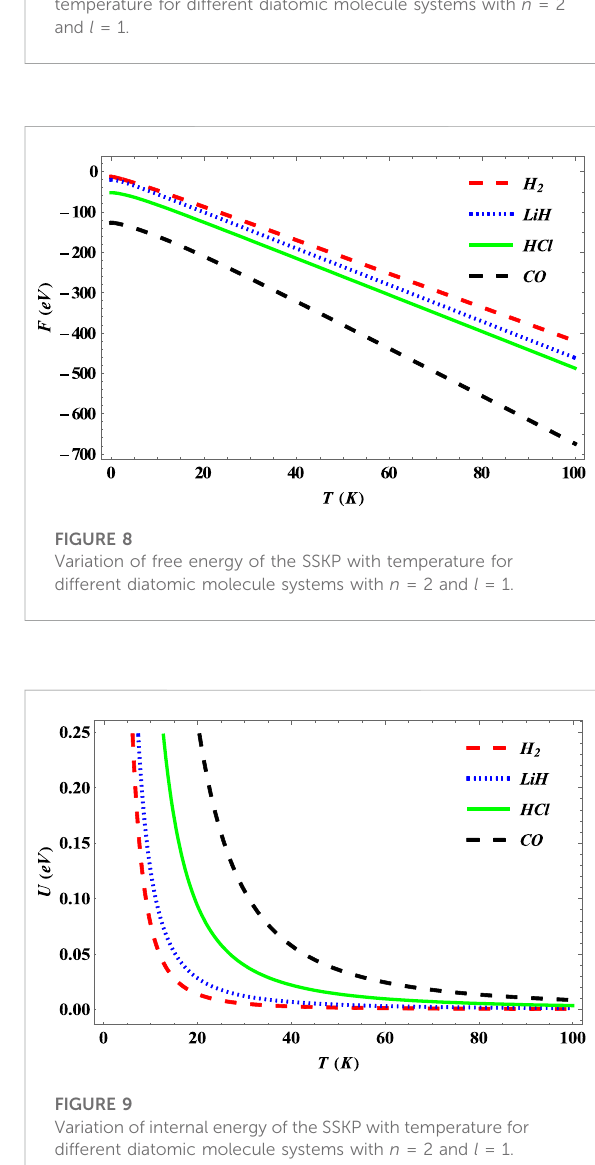
FIGURE 10 Variation of entropy of the SSKP with temperature for different diatomic molecule systems with n = 2 and l = 1.